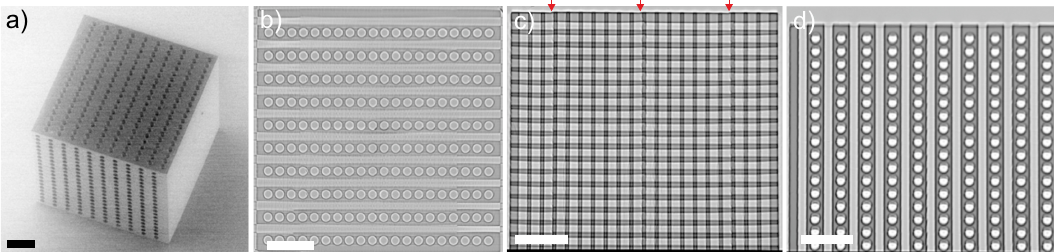
Figure 1. Images of the lens array: ( a ) scanning electron microscope (SEM) image where the two planes of cylinder lenses can be seen (X-ray direction in use is perpendicular to the smooth surface); ( b ) tomogram through a horizontal plane; ( c , d ) radiographs from the lateral and front side. In ( c ) three vertical irregularities can be seen which originate from the printing process (marked with red arrows). Scale bars are 200 µ